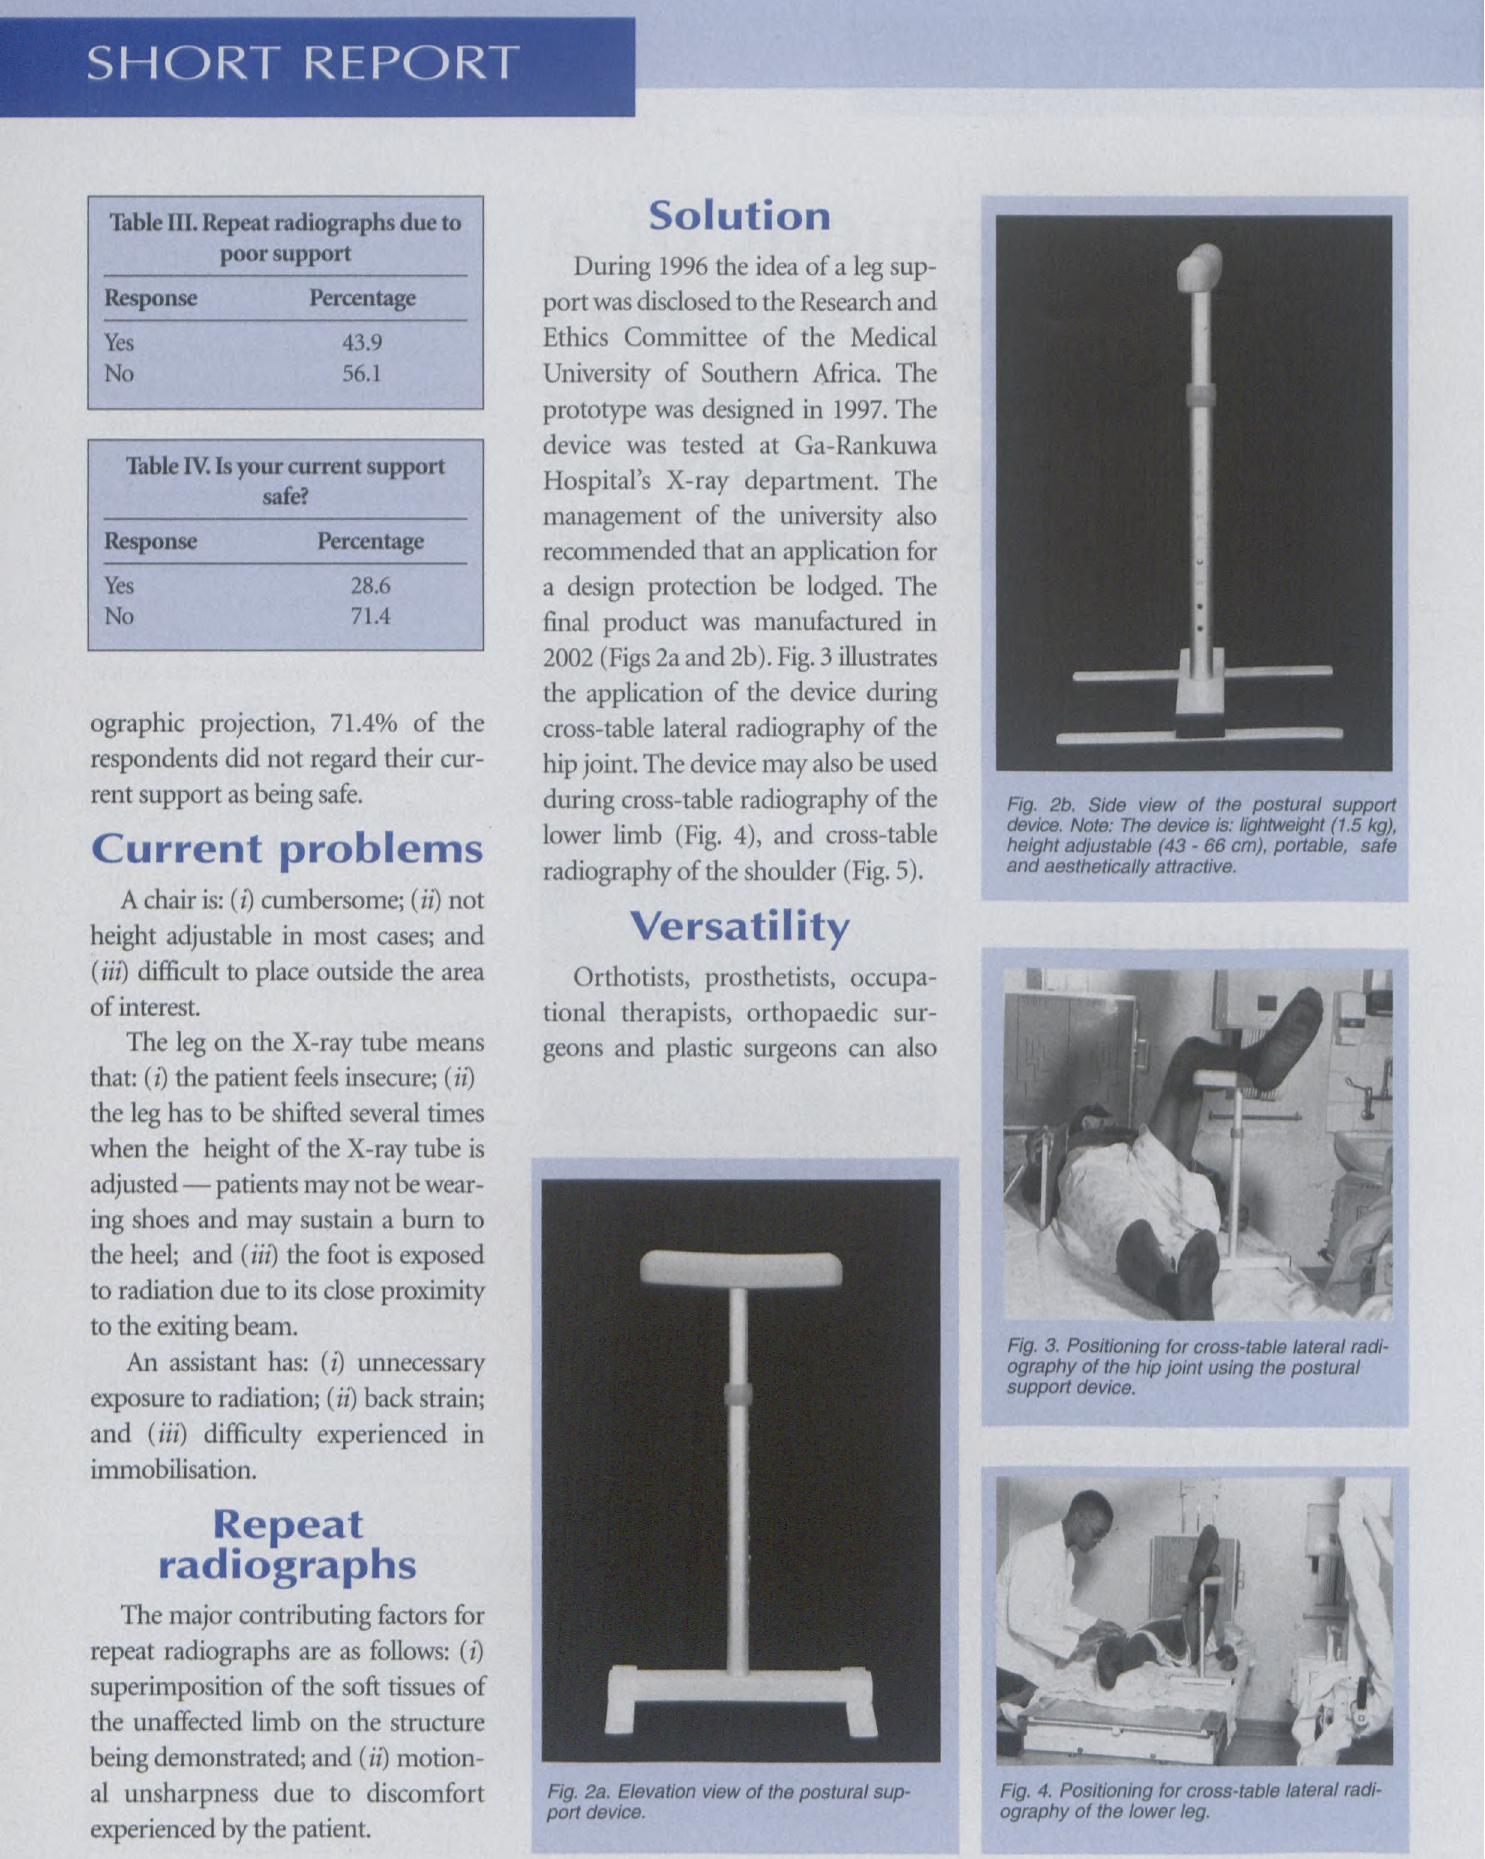
Fig. 4. Positioning for cross-table lateral radio ography of the lower